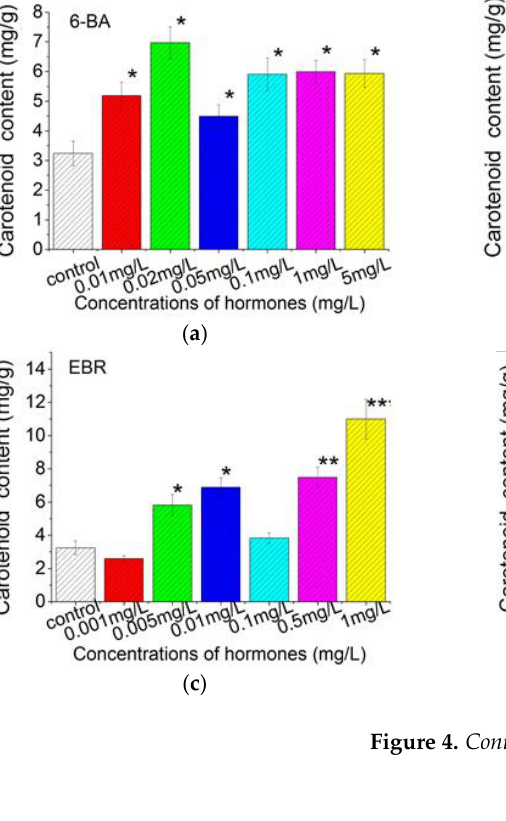
Figure 3. The total soluble protein contents of C. pyrenodiosa ZF strain at different concentrations of